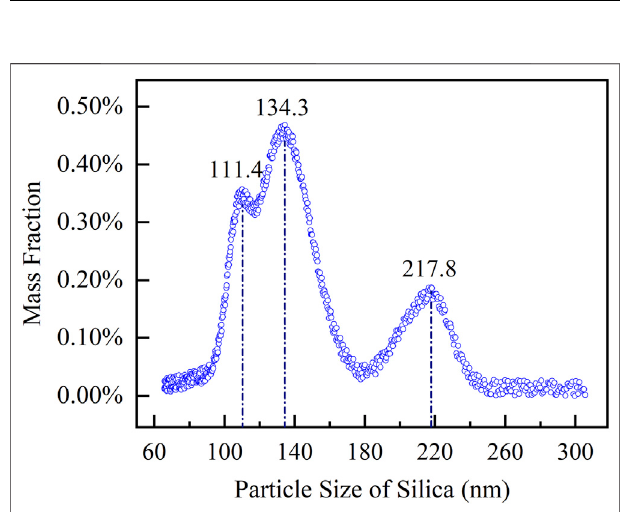
FIGURE 8 | The particle size distribution of